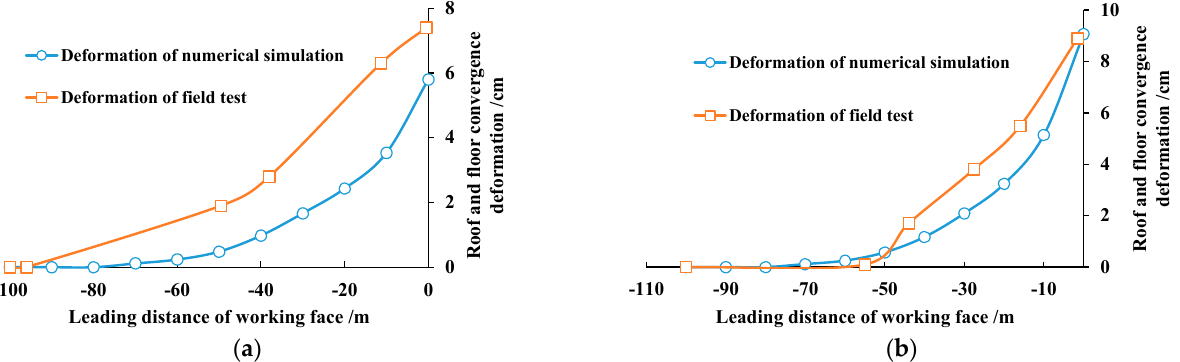
Figure 5. Comparison curve between the numerical test and field test. ( a ) Deformation of the haulage roadway. ( b ) Deformation of the ventilation roadway.